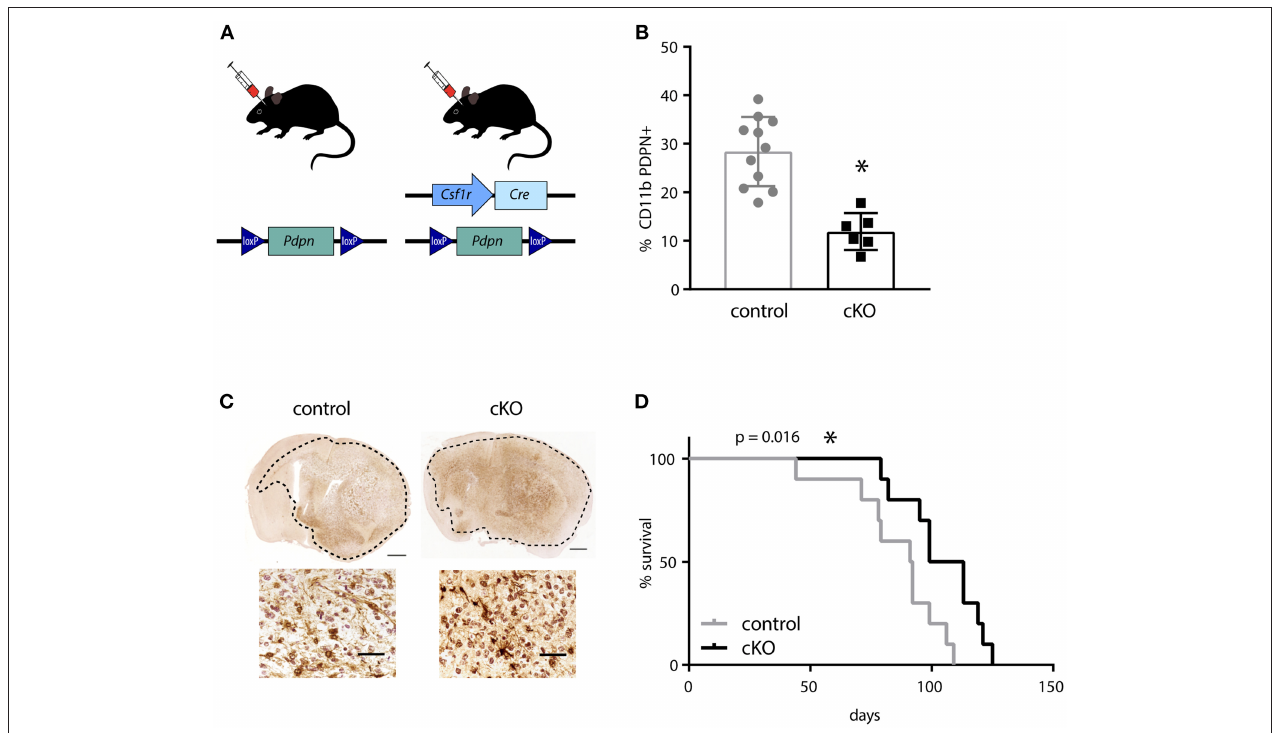
FIGURE 2 | The deletion of Pdpn in myeloid cells improves survival of glioma bearing mice. (A) Schematic representation of genotypes applied for syngeneic transplantations of high-grade glioma cells. (B) Percentage of PDPN + cells (of all CD11b + cells) in mandibular lymph nodes of control and conditional knockout (cKO) animals, assessed by flow cytometry, data represent mean and SD, p = 0.0001; Student’s t -test. (C) Immunohistochemical staining of mCherry positive glioma cells implanted in control and cKO brains, scale bar 1mm and 50 µ m for magnifications. (D) Kaplan-Meier survival analysis showed significantly prolonged survival of cKO animals, p = 0.016 (log-rank test); n = 10. * p < 0.05, ** p <